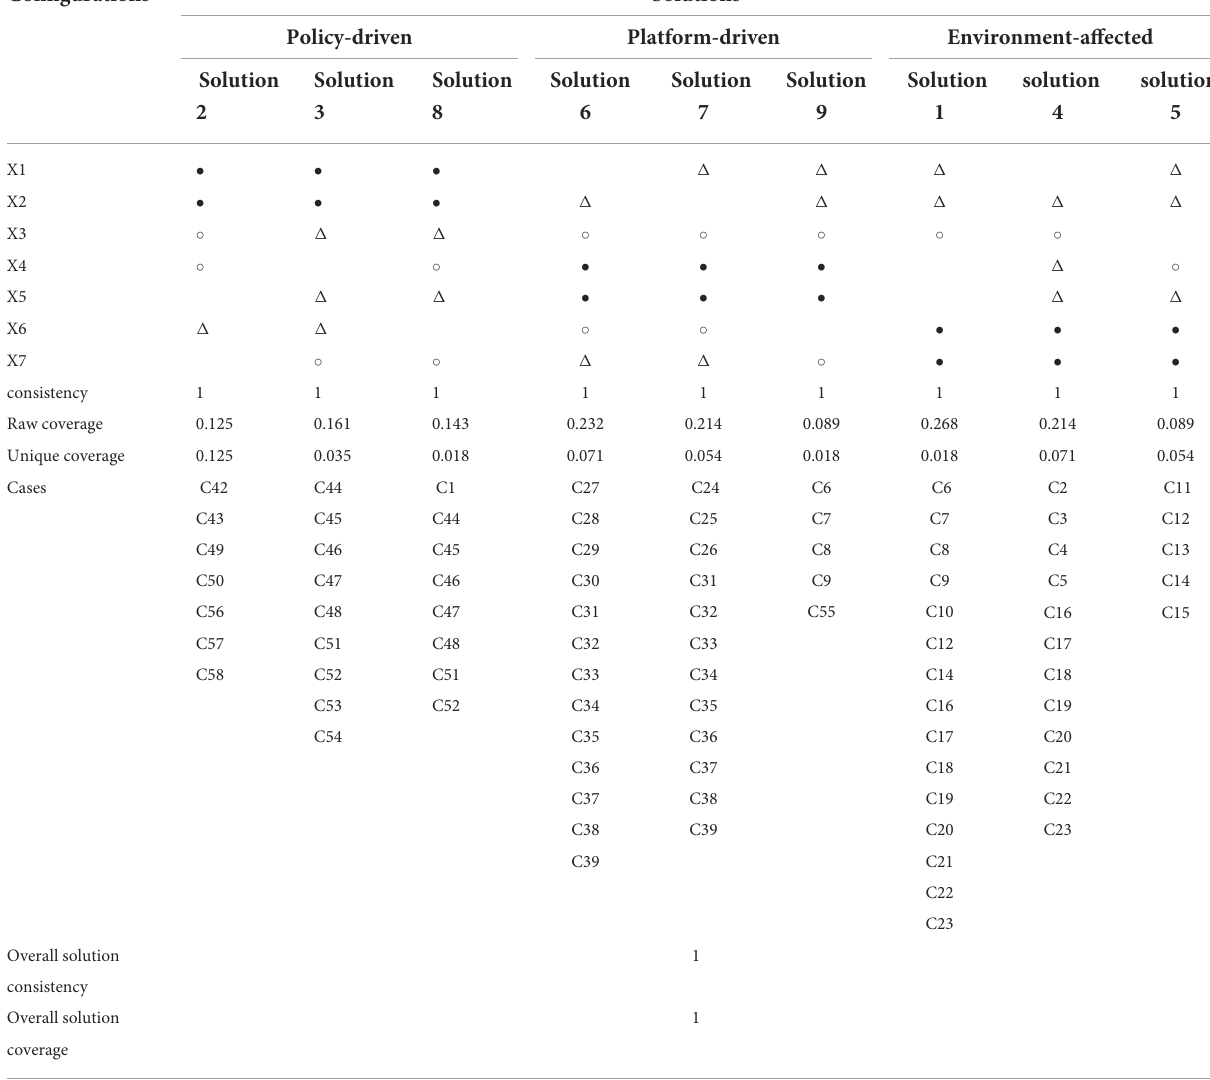
TABLE 3 Configurations for factors influencing integrity education of chinese college